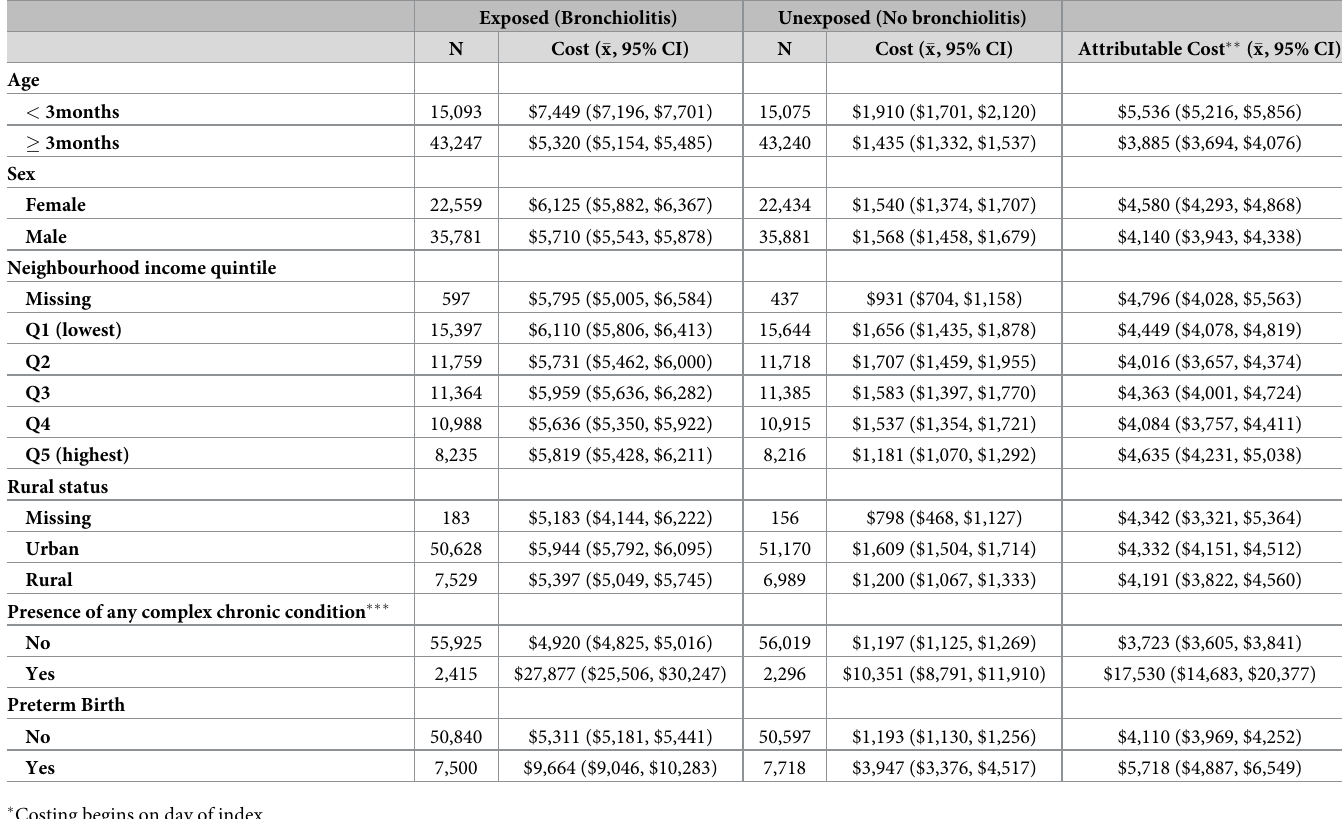
Table 3. Mean attributable costs of bronchiolitis over one year (365 days) following index visit (stratified